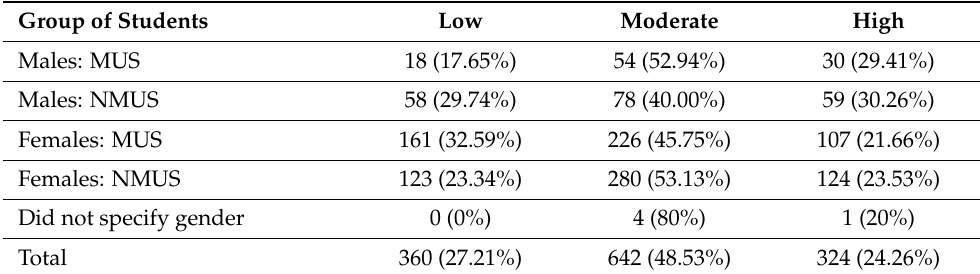
Table 3. Physical activity categories based on IPAQ-SF scoring protocol; MUS—medical university students, NMUS—non-medical university